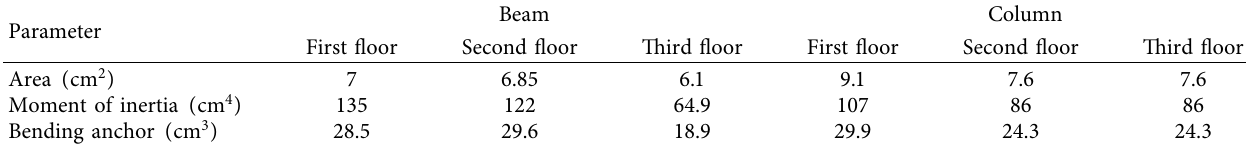
Table 2: Specifications of the sections of the elements used